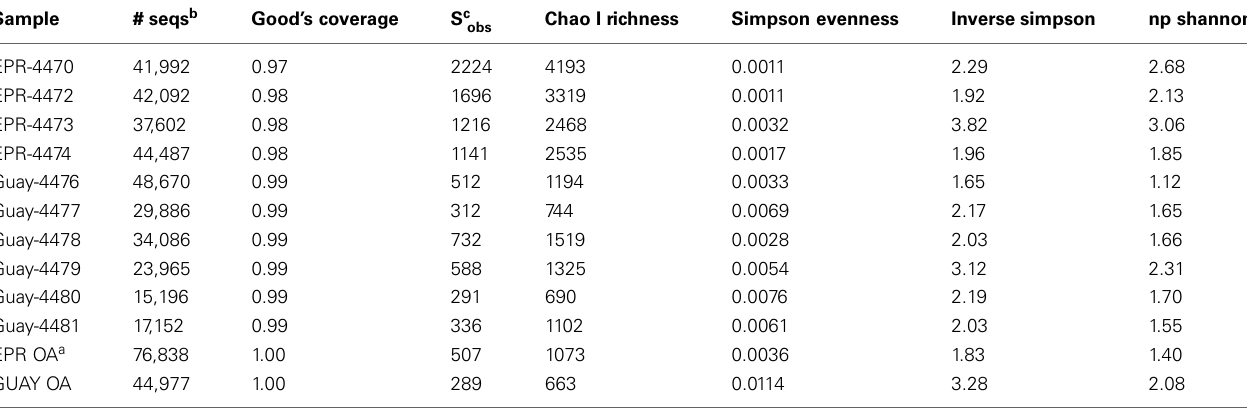
Table 3 | Diversity estimates from 16S rRNA amplicon libraries of diffuse flow vent samples collected at 9 ◦ N East Pacific Rise (EPR) and Guaymas Basin (Guay) hydrothermal vent sites.